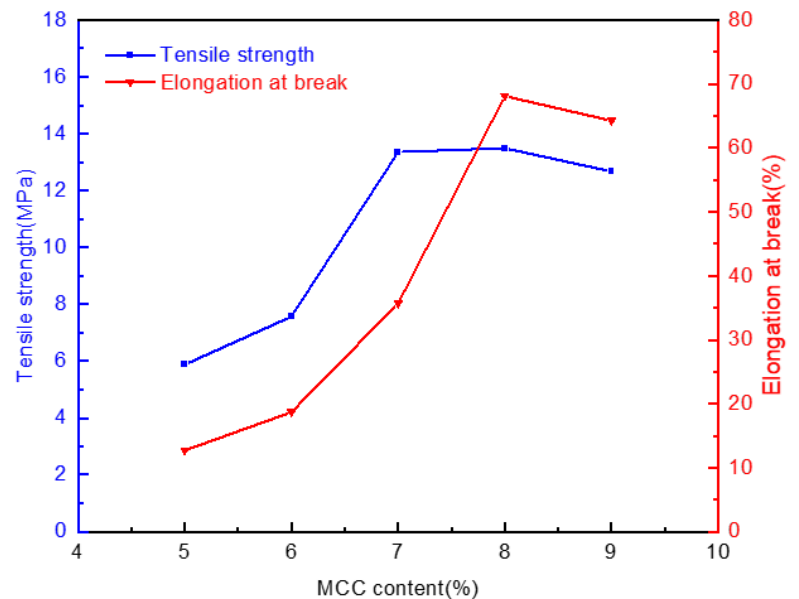
Figure 7. Effect of jute MCC content in casting liquid on the mechanical properties of membrane.